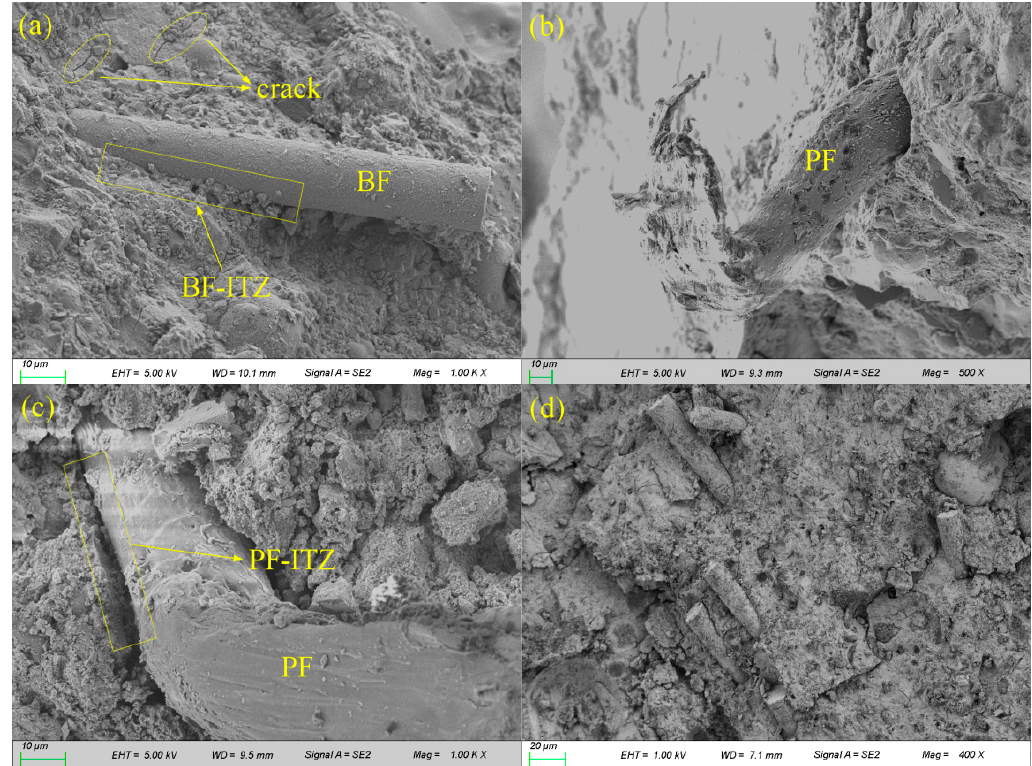
Figure 13. Morphology of BF and PF in the HBPRC before erosion: ( a ) BC-0.1; ( b ) and ( c ) PC-0.1; ( d ) BPC-0.2.